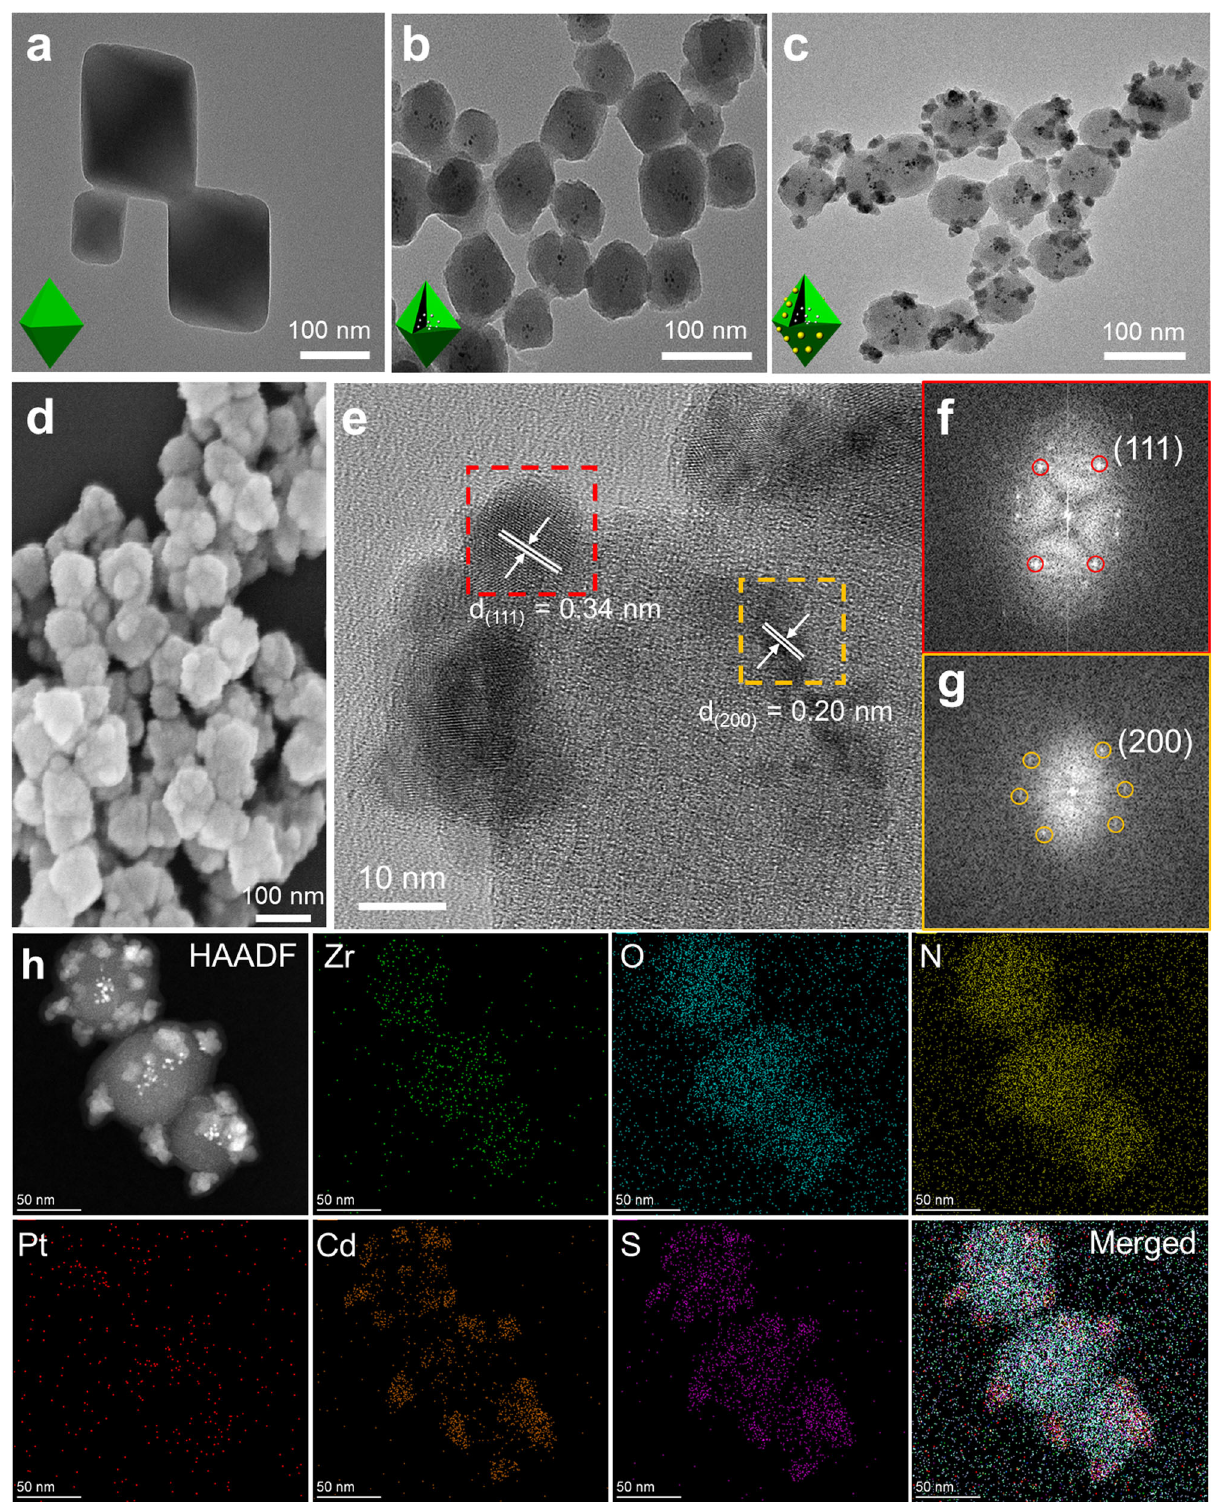
Fig. 1 Structural characterization of the nanocrystals. a – c Representative transmission electron microscopy (TEM) images of ( a ) NH 2 -UiO-66, ( b ) Pt@NH 2 -UiO-66, and ( c ) Pt@NH 2 -UiO-66/CdS, inset: schematic representation (lower left). d Scanning electron microscopy image of Pt@NH 2 -UiO-66/ CdS. e High-resolution TEM image of a single Pt@NH 2 -UiO-66/CdS. f , g Fast Fourier transform patterns of the CdS phase from <111> direction at the left region of ( e ) and the Pt phase from <001> direction at the right region of ( e) , respectively. h , High-angle annular dark- fi eld (HAADF) scanning TEM and energy-dispersive spectrometry elemental mapping images of Pt@NH 2 -UiO-66/CdS.